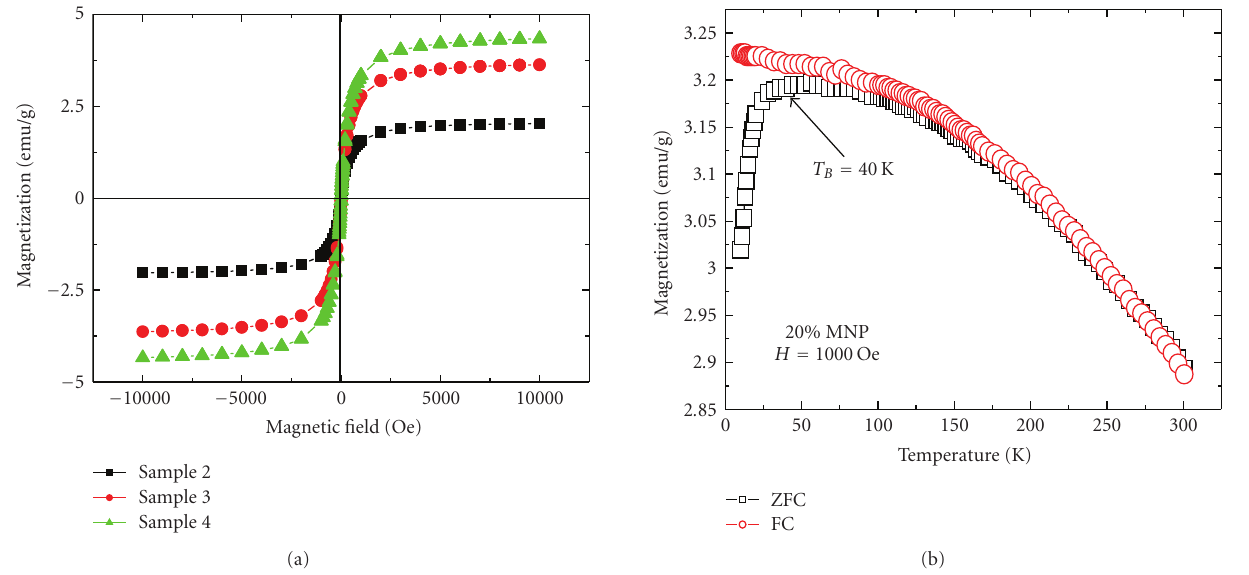
Figure 6: SQUID data of magnetic nanocomposite spheres. (a) Saturation of specific magnetization with an applied field of approximately 5 000Oe at 300 K. (b) Typical temperature dependence of magnetization, showing a superparamagnetic behavior with a blocking temperature near 40